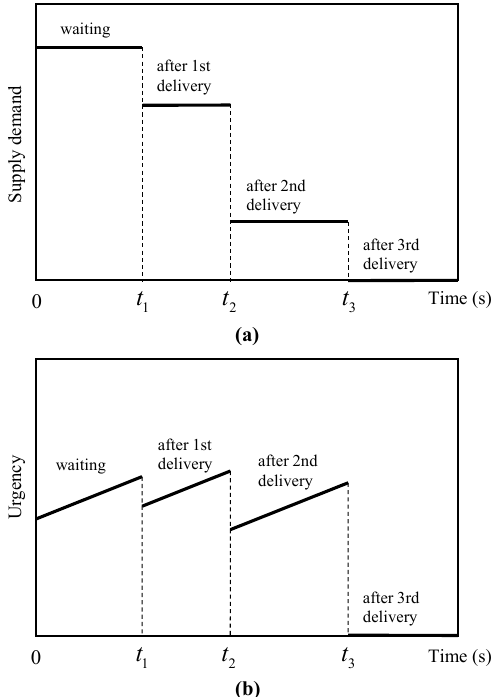
Figure 1. Illustration of the task information changes in the process with three deliveries. ( a ) Changes in the demand in the delivery process. ( b ) Changes in the urgency in the delivery